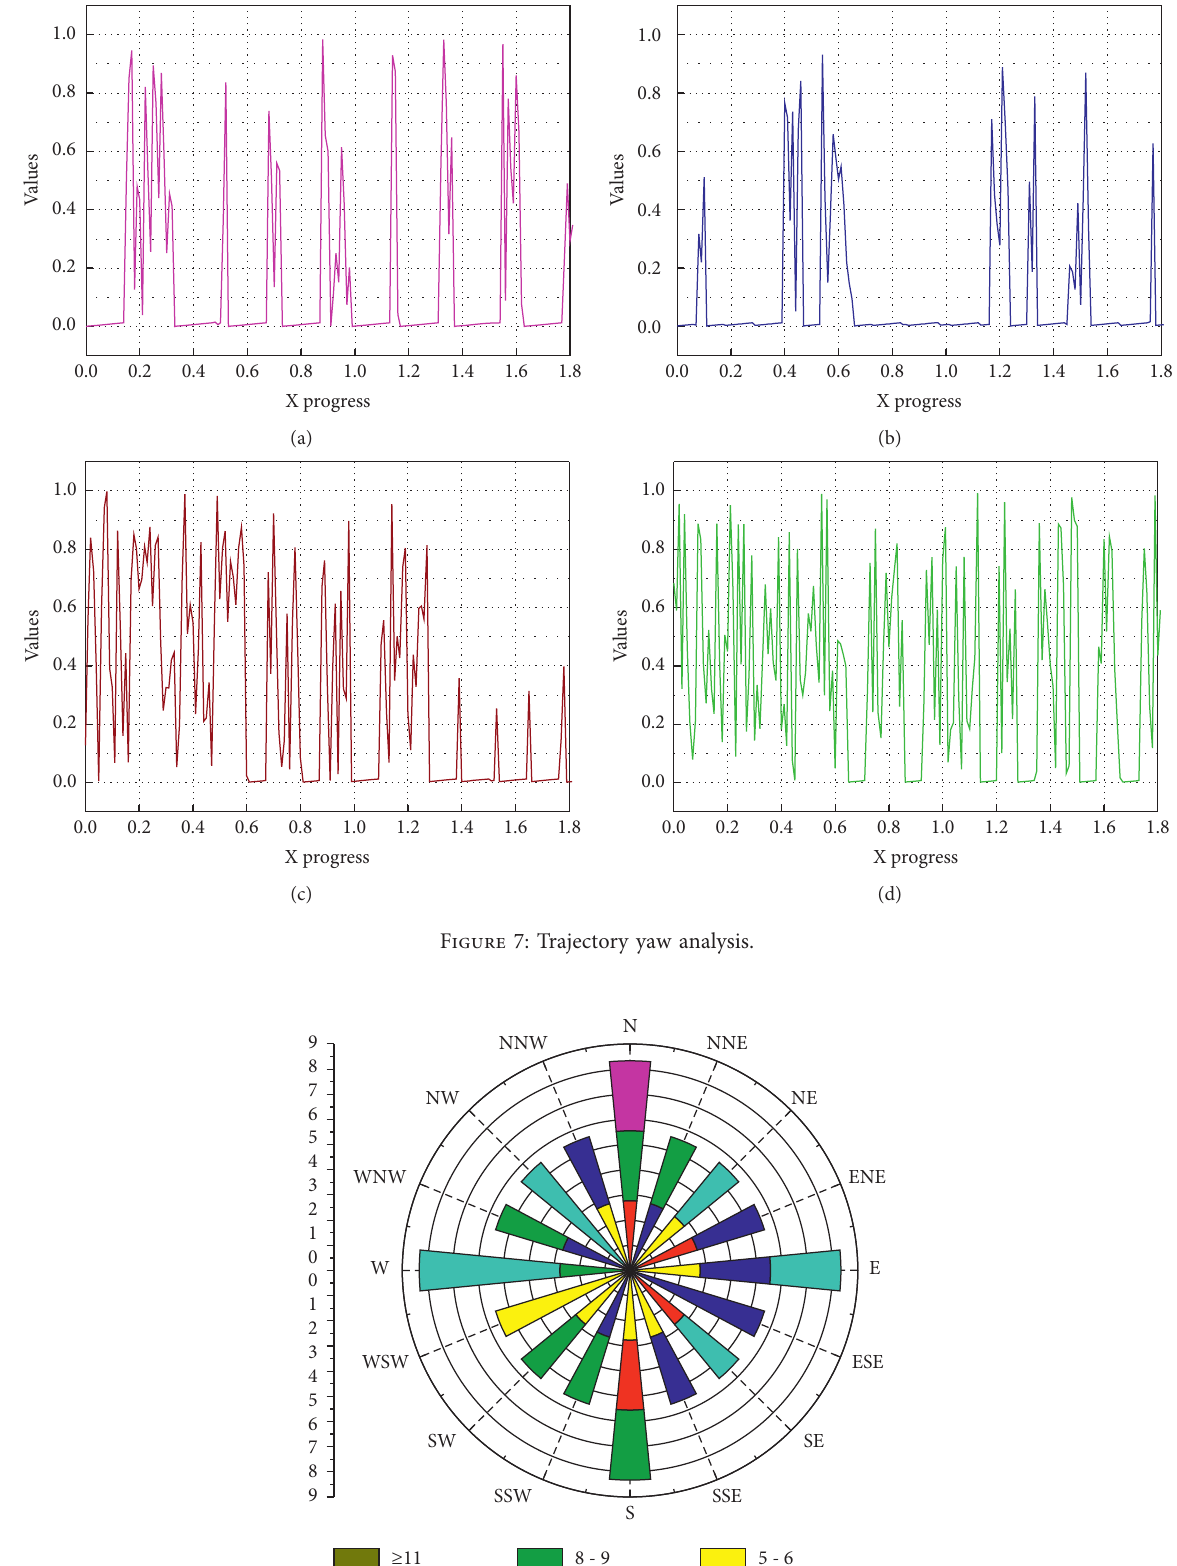
Figure 8: Rose diagram